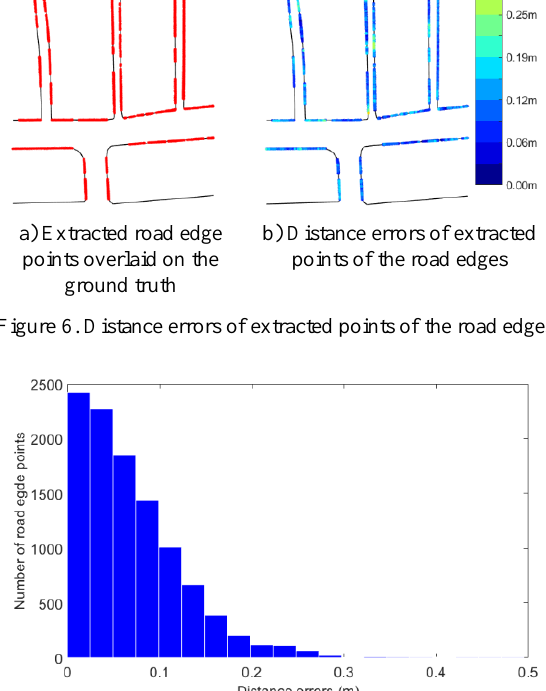
Figure 7. Distribution of the distance